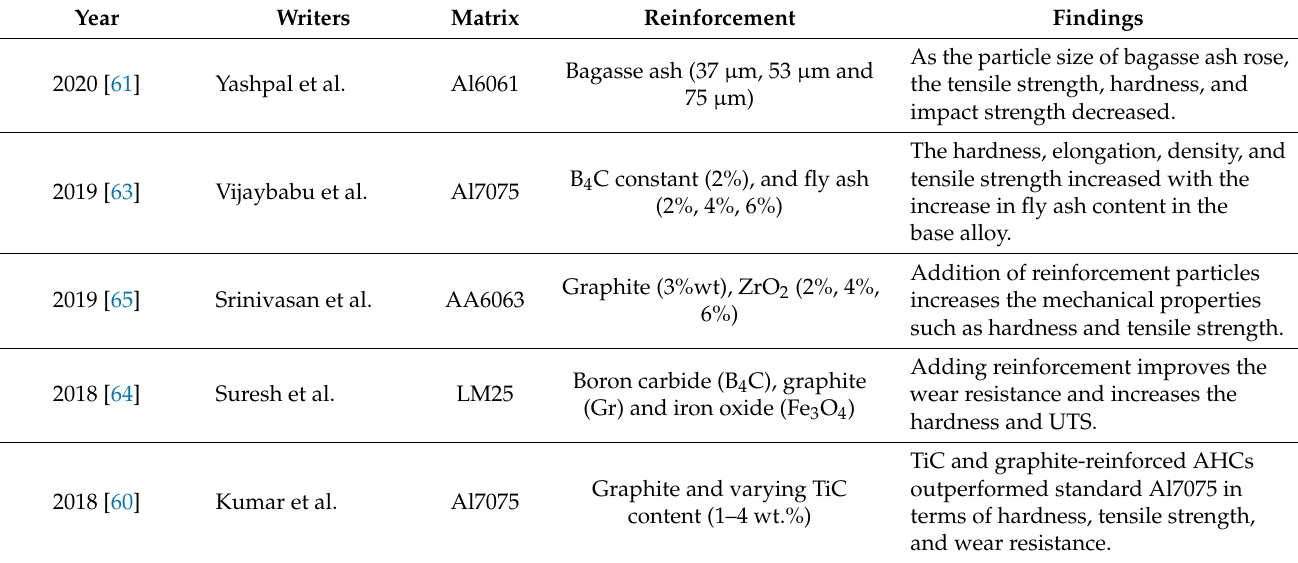
Table 5. Research articles about stir casting